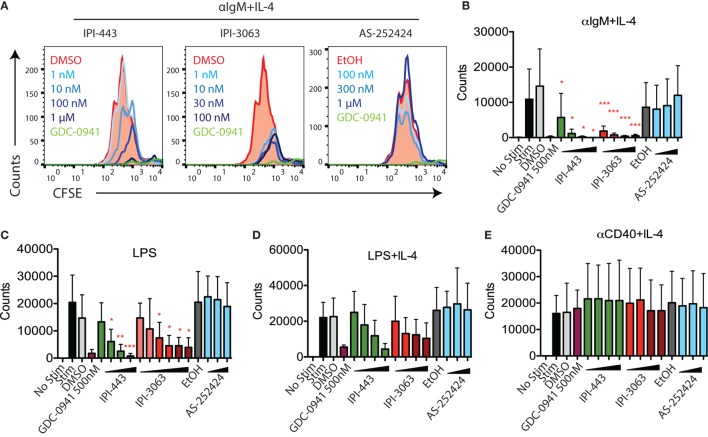
IPI-3063 potently inhibits mouse B cell proliferation. Total splenocytes (A,B) or purified B cells (C–E) were pretreated with inhibitors for 30 min, then stimulated with (A,B) αIgM + IL-4 for 72 h, (C–E) LPS + IL-4 for 96 h, LPS for 72 h, or αCD40 + IL-4 for 96 h. Concentrations used were 1 nM, 10 nM, 100 nM, 1 µM for IPI-443 and 1, 10, 30, 100 nM for IPI-3063. AS252424 concentrations were 100 nM, 300 nM, and 1 µM, and GDC-0941 was at 500 nM. The experiments in panel (C) include low concentrations of IPI-3063 (0.01 and 0.1 nM) Total numbers were determined by the number of B220+7AAD−CFSElo cells. Samples were collected by time (*P < 0.05, **P < 0.001, ***P < 0.0001 one-way ANOVA with Newman–Keuls multiple comparison test).